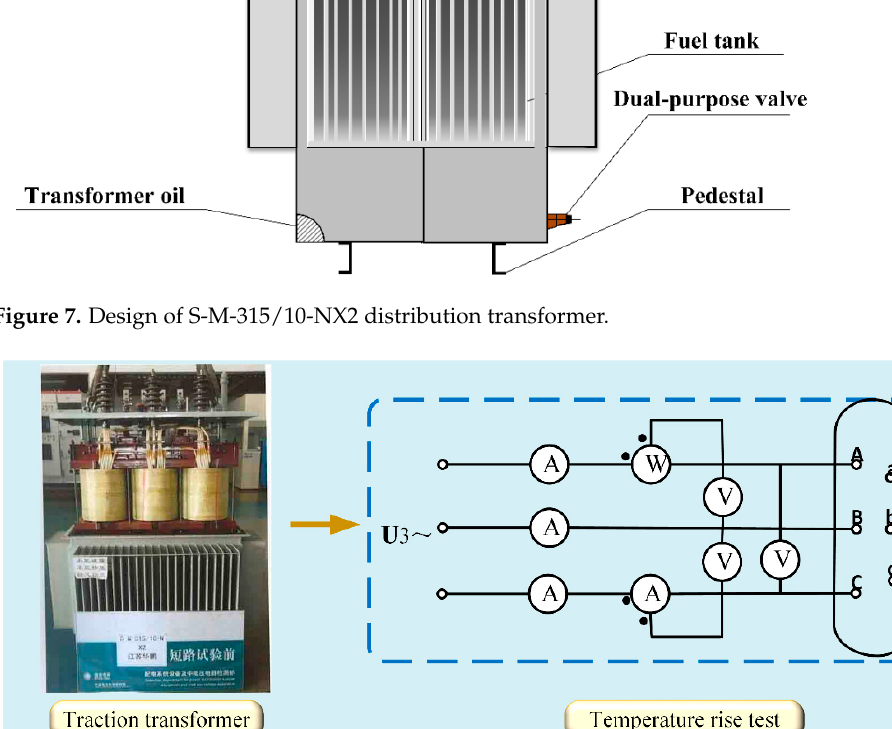
Figure 8. Wiring diagram of temperature rise test.